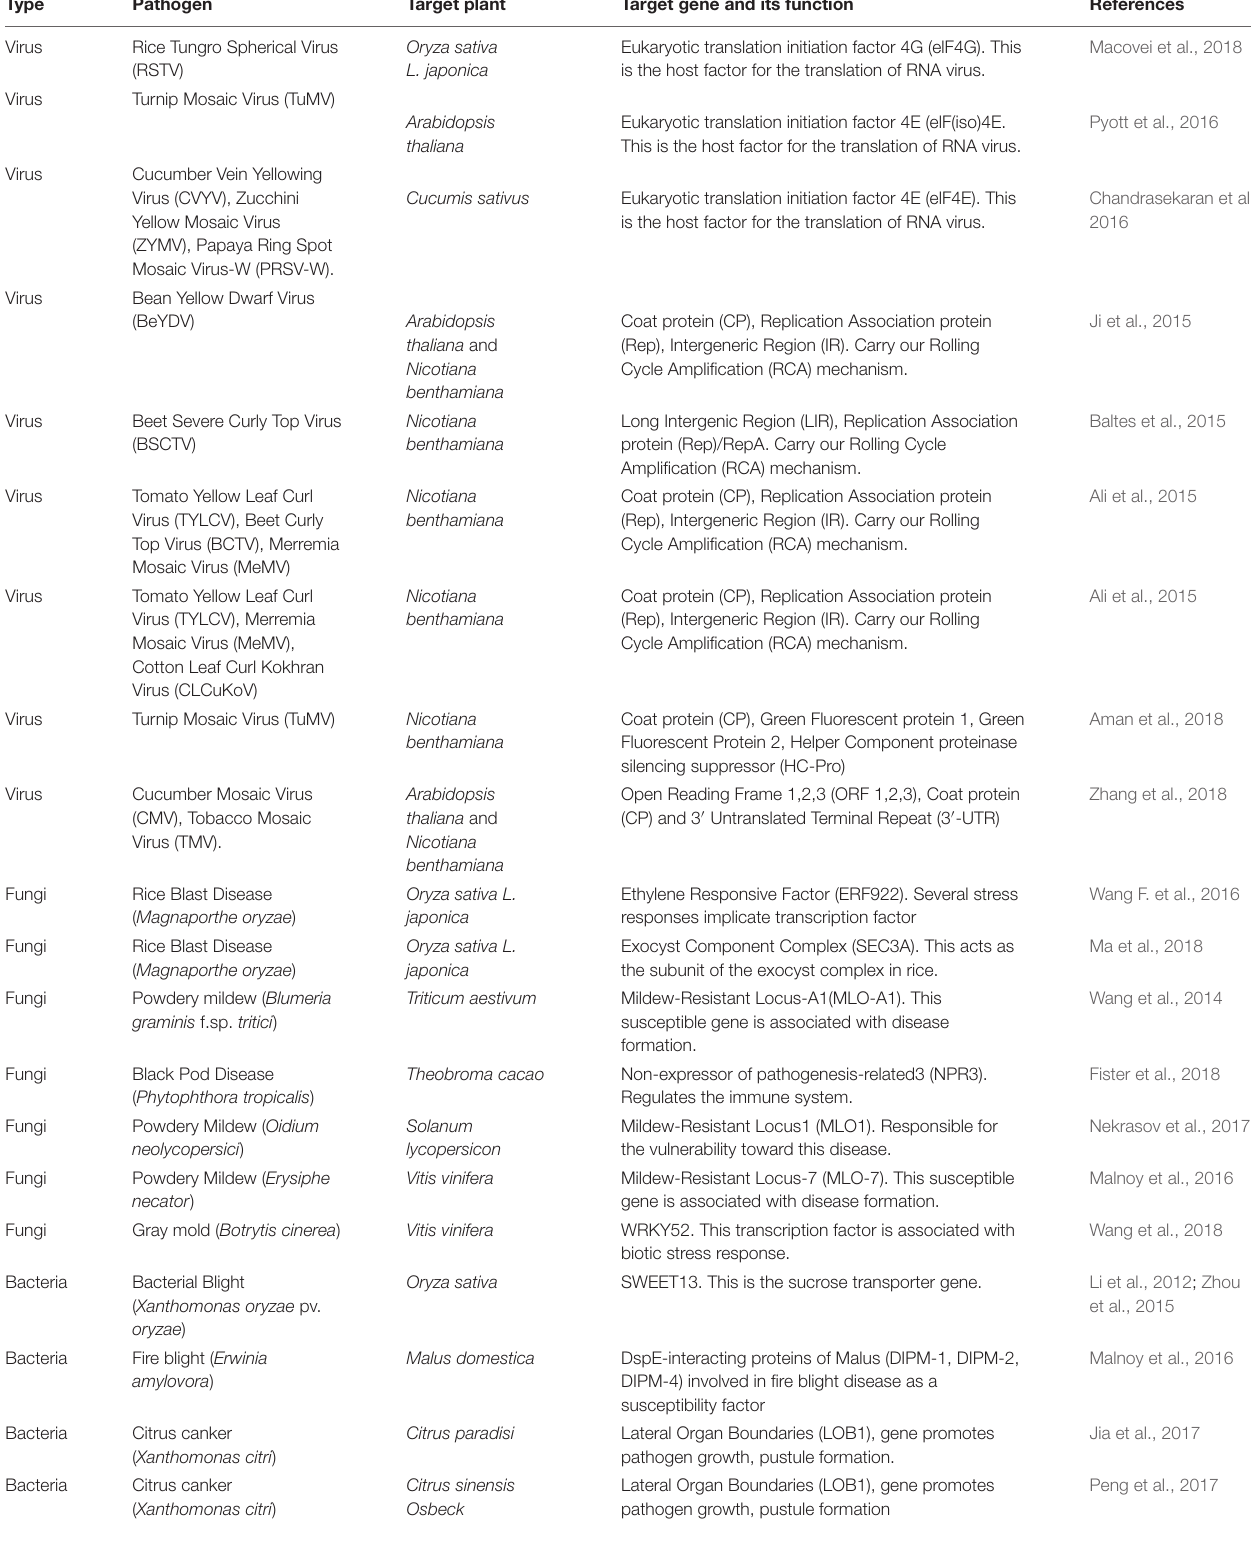
TABLE 4 | CRISPR/Cas-targeted editing in plants against viruses, fungi, and